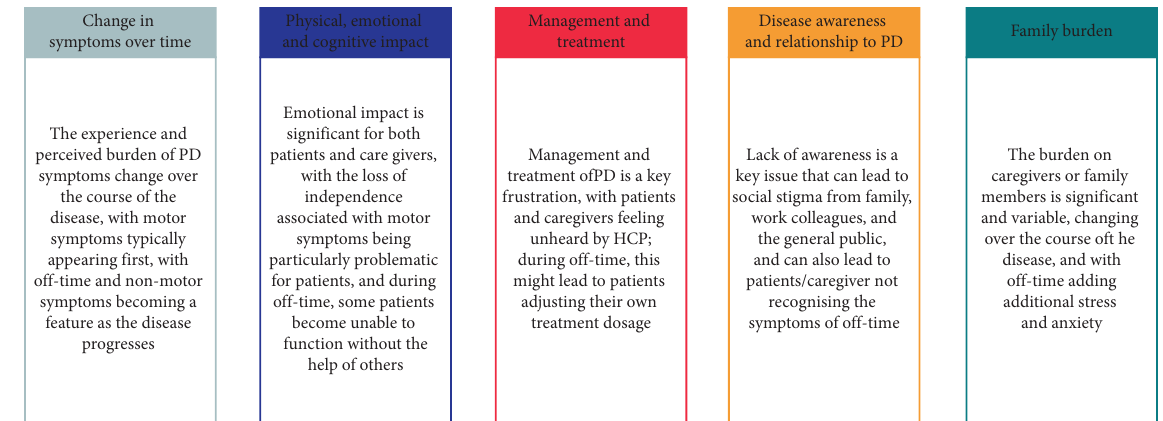
Figure 5: Summary of factors that impair Quality of Life identifed from the natural language processing analysis and qualitative deep